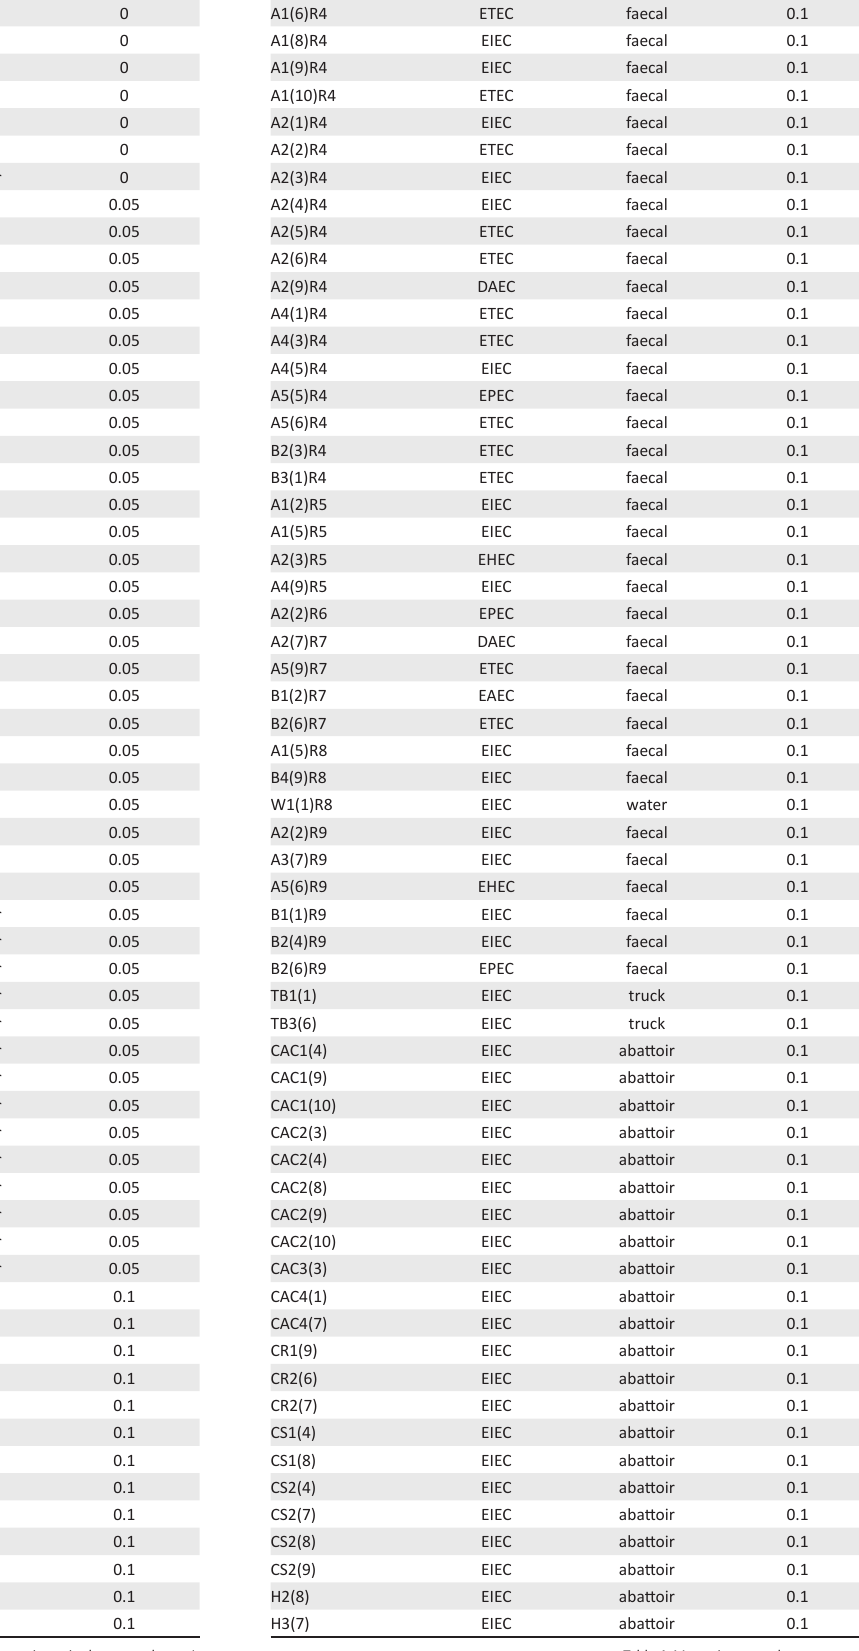
TABLE 4-A1 (Continues...): Multiple-antibiotic resistance index for all diarrheagenic E. coli pathotypes along the farm-to-fork continuum. Bacterial ID DEC